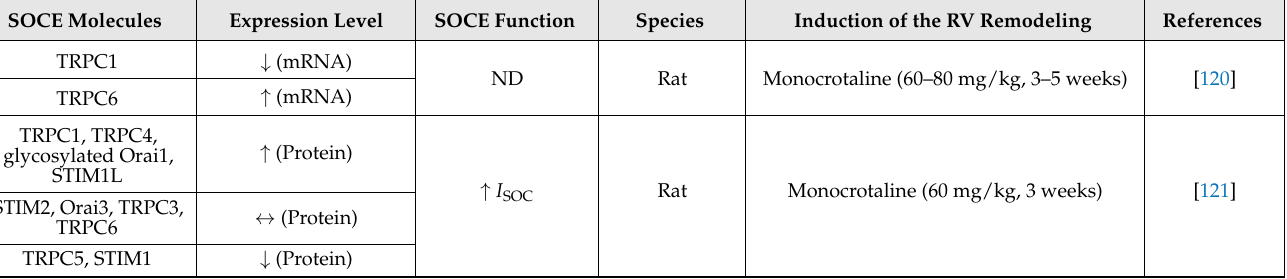
Table 2. SOCE molecules expression after hypertrophic stresses of the Right Ventricle. ↑ : increase; ↔ : no change ↓ decrease; ND: not